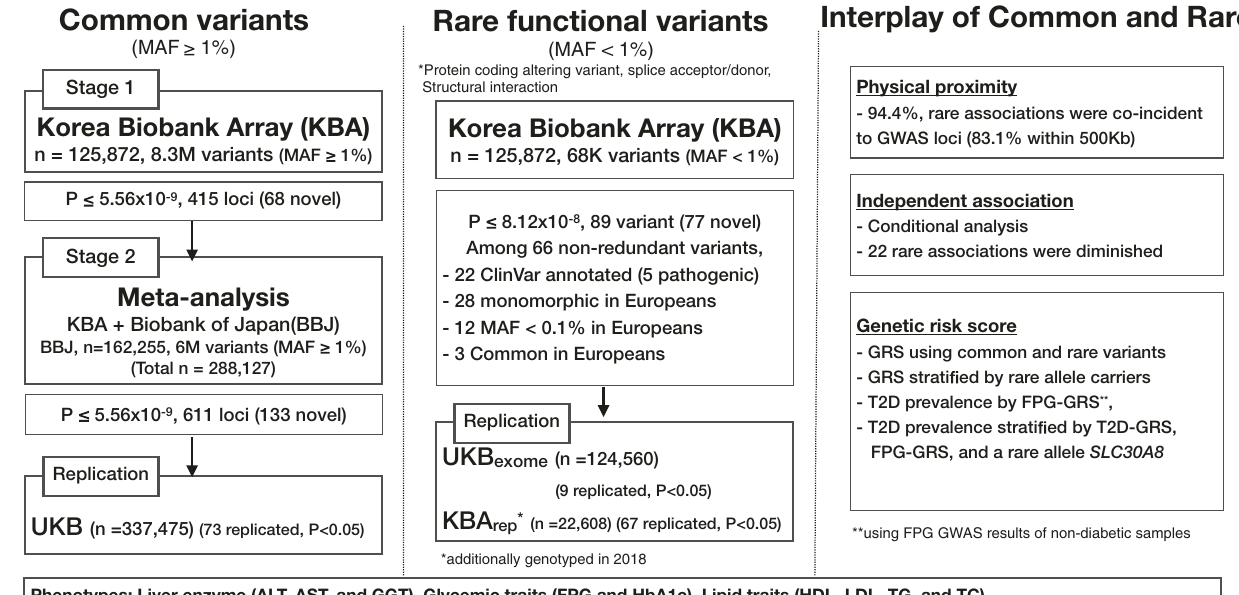
Fig. 1 | Overall analysis scheme. Flow chart of the overall analysis including summarized results of common variants, rare functional variants, and interplay of common and rare